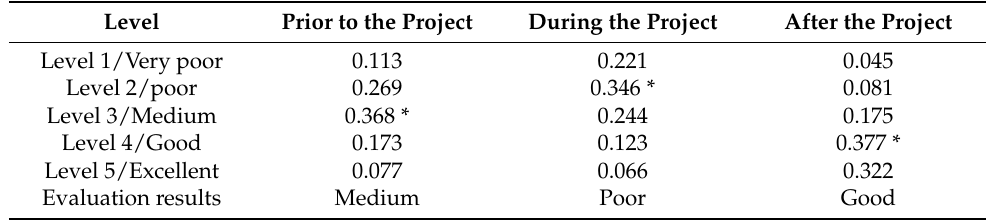
Table 5. Membership degrees corresponding to different ecosystem levels at each time node of waterway construction. Level Prior to the Project During the Project After the Project Level 1/Very poor 0.113 0.221 0.045 Level 2/poor 0.269 0.346 * 0.081 Level 3/Medium 0.368 * 0.244 0.175 Level 4/Good 0.173 0.123 0.377 * Level 5/Excellent 0.077 0.066 0.322 Evaluation results Medium Poor